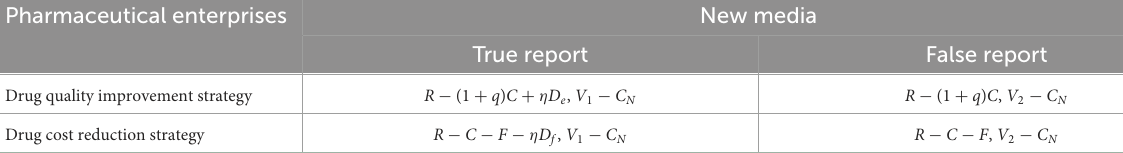
TABLE 2 Drug quality strategy game matrix.